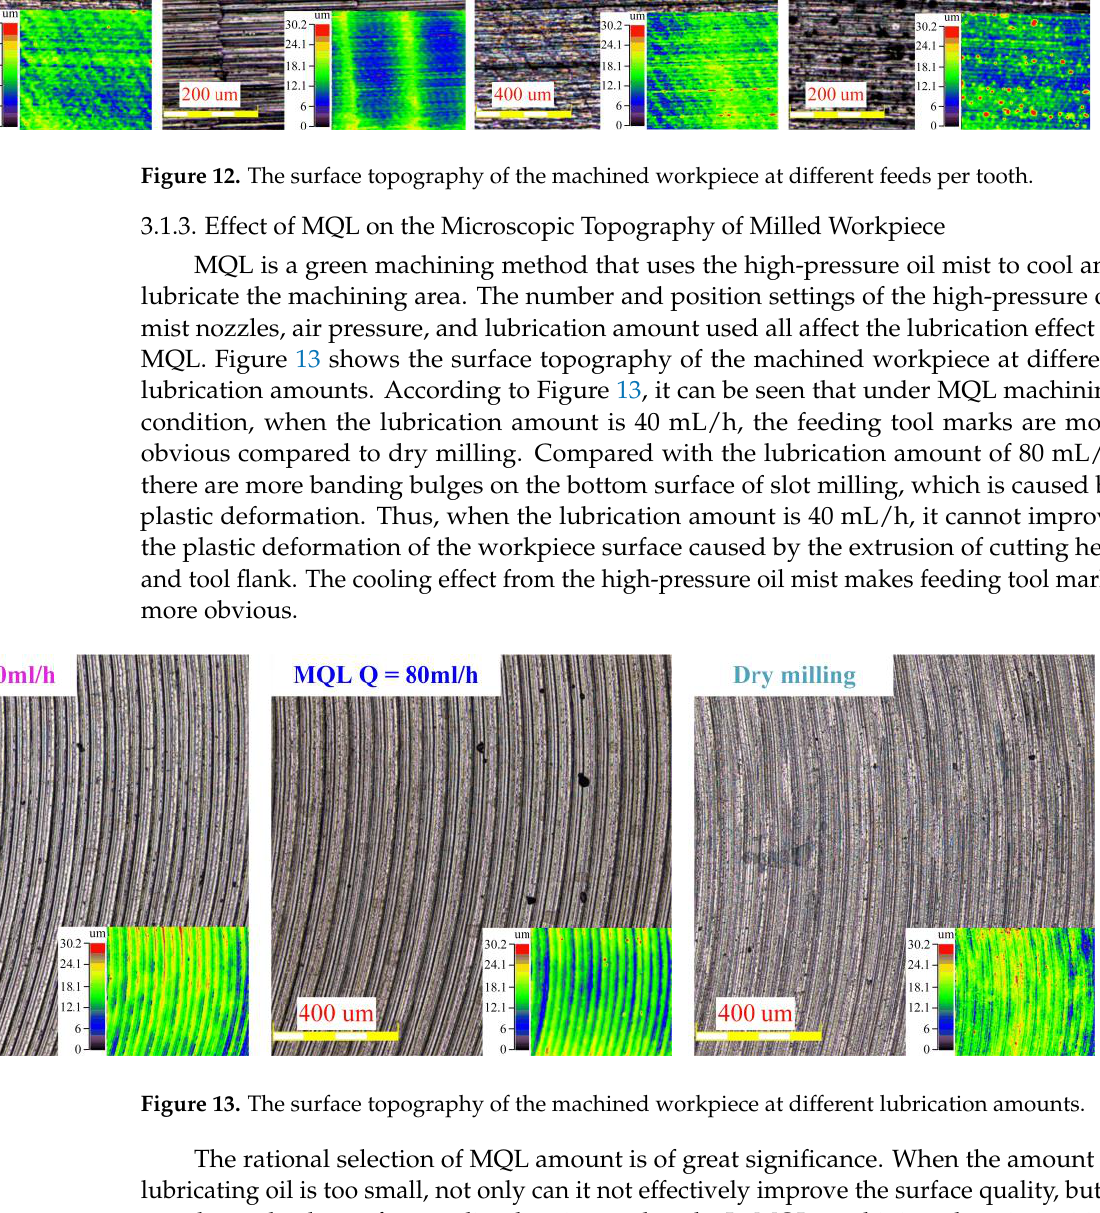
Figure 12. The surface topography of the machined workpiece at different feeds per tooth.